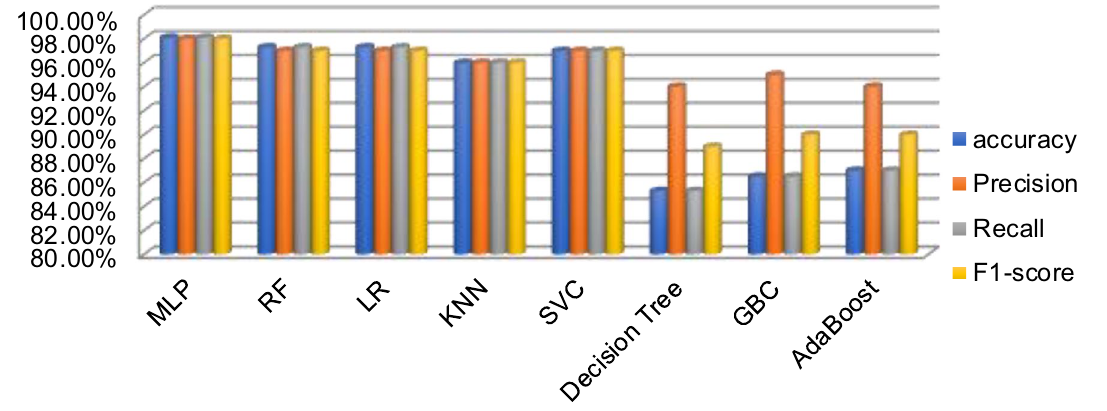
Fig. 8 Highest performance comparison of different classification algorithms on top 30